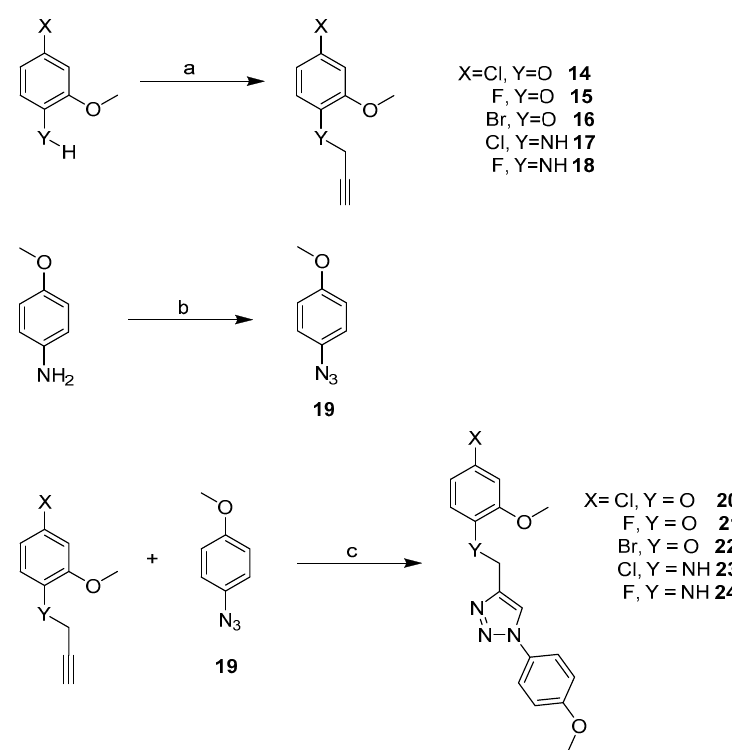
Scheme 4. Synthesis of the triazole-linked diaryl compounds via ‘click’ chemistry. Reagents and conditions : ( a ) Propargyl bromide, K 2 CO 3 , DMF, 55 °C to r.t., 4 h, Y = O, X = Cl (75%), F (75%), Br